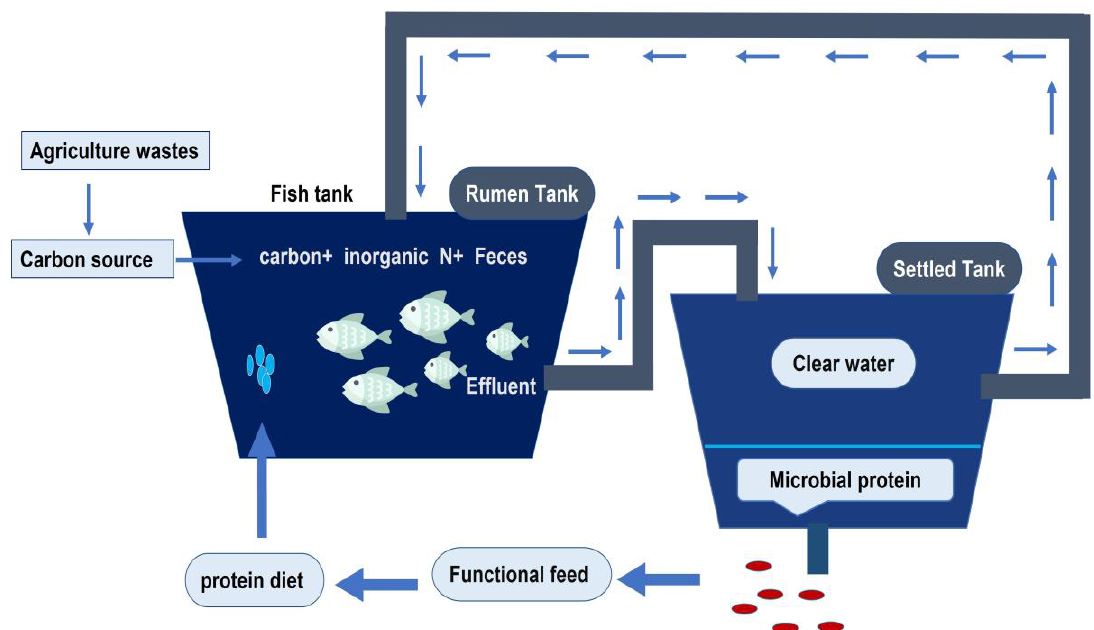
Figure 3. Typical illustration of tilapia farming using Biofloc Technology.